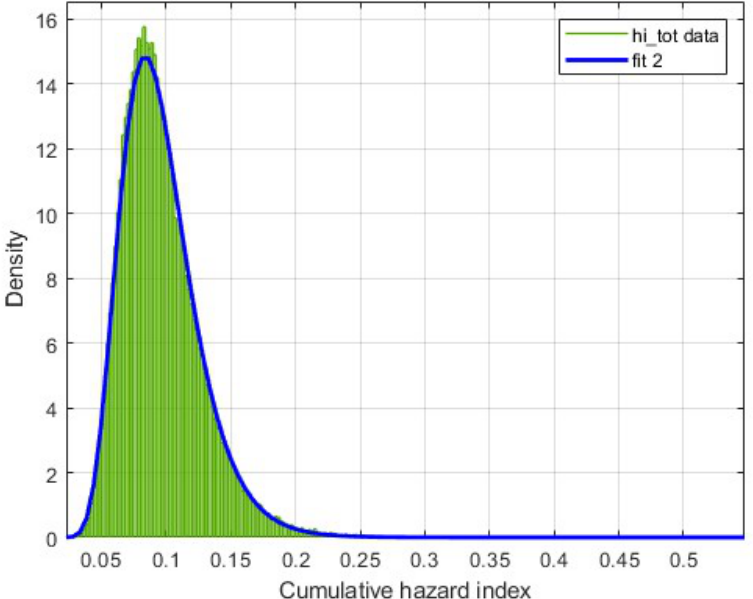
Figure 8. Probability distribution of the cumulative hazard index resulting from the Monte-Carlo simulations.